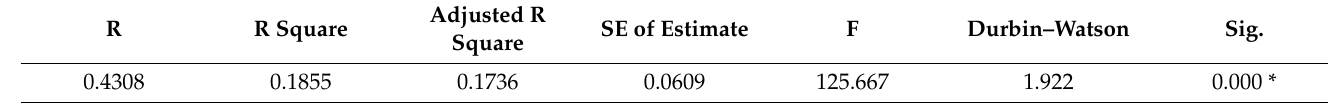
Table 5. Results of the influential power test of the multiple regression